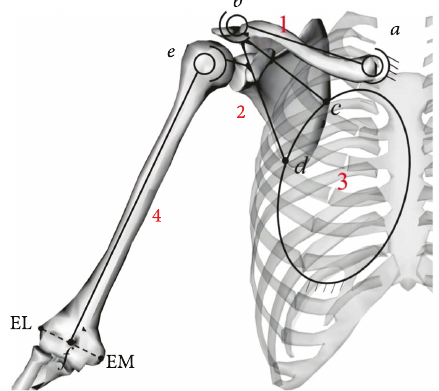
Figure 1: Schematic diagram of the shoulder